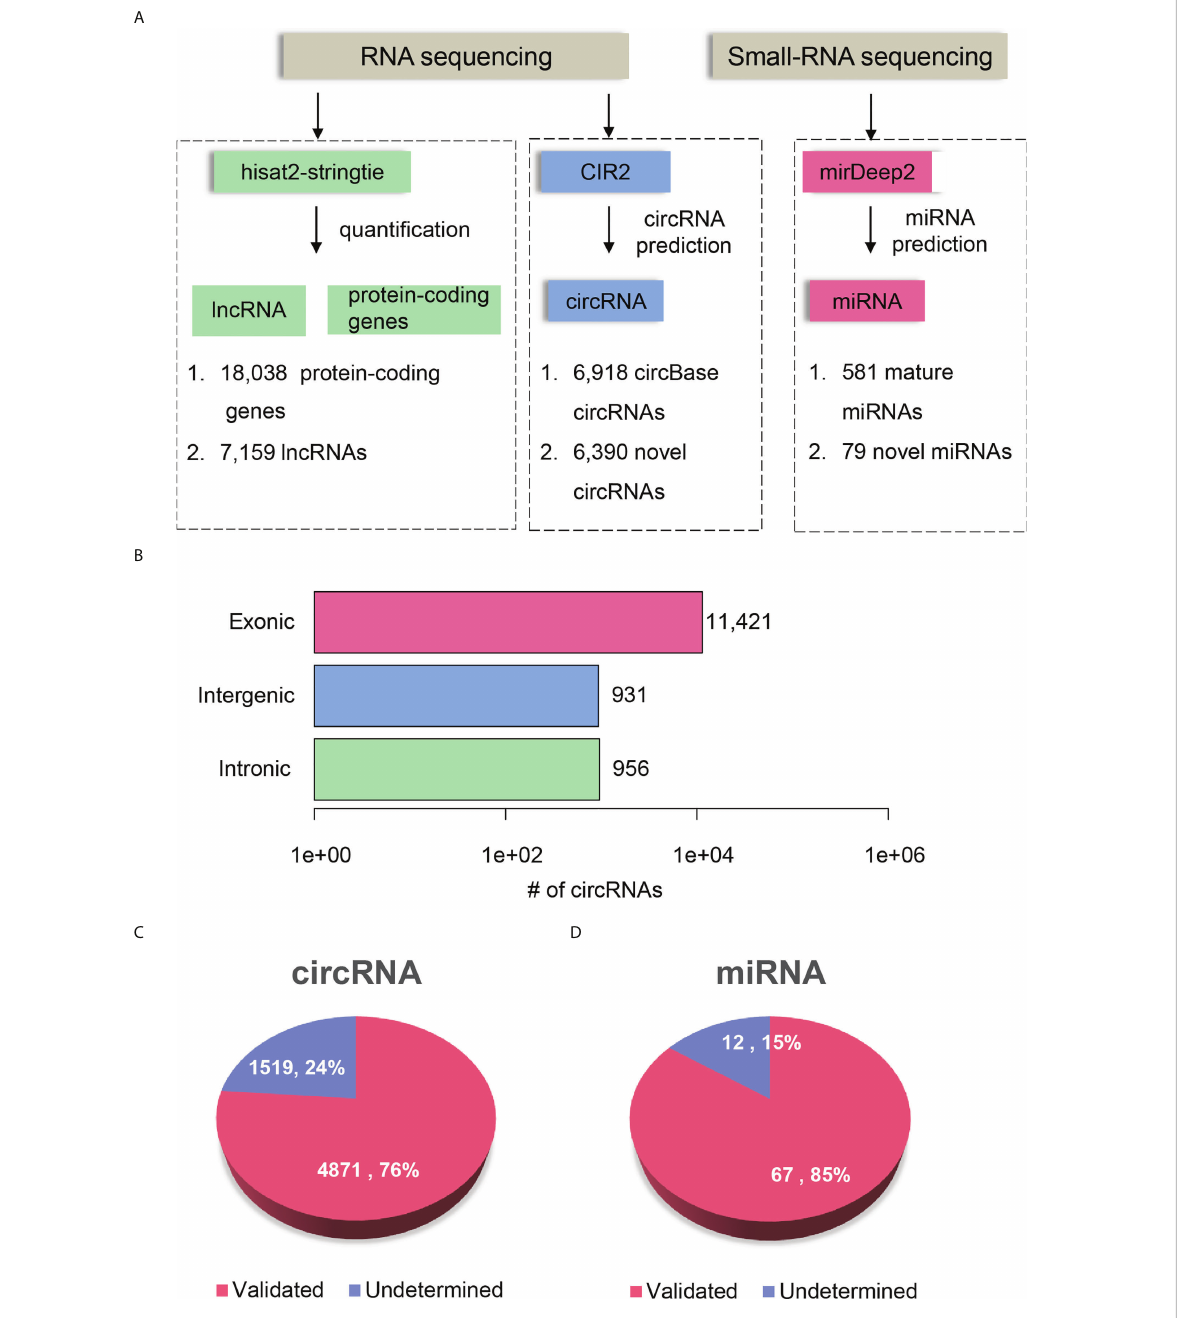
FIGURE 2 Transcriptome pro fi ling of non-coding RNAs by RNA-seq in HCC. (A) The work fl ow for ncRNA detection and quanti fi cation. The circRNA and miRNA detection were performed by CIRI2 and miRDeep2, respectively. (B) The number of circRNAs originated from different genomic regions, including exonic, intronic, and intergenic regions. The novel circRNAs and miRNAs are displayed in pie charts of (C, D) . The pink and blue parts represent the validated and undetermined circRNAs/miRNAs by the independent dataset,